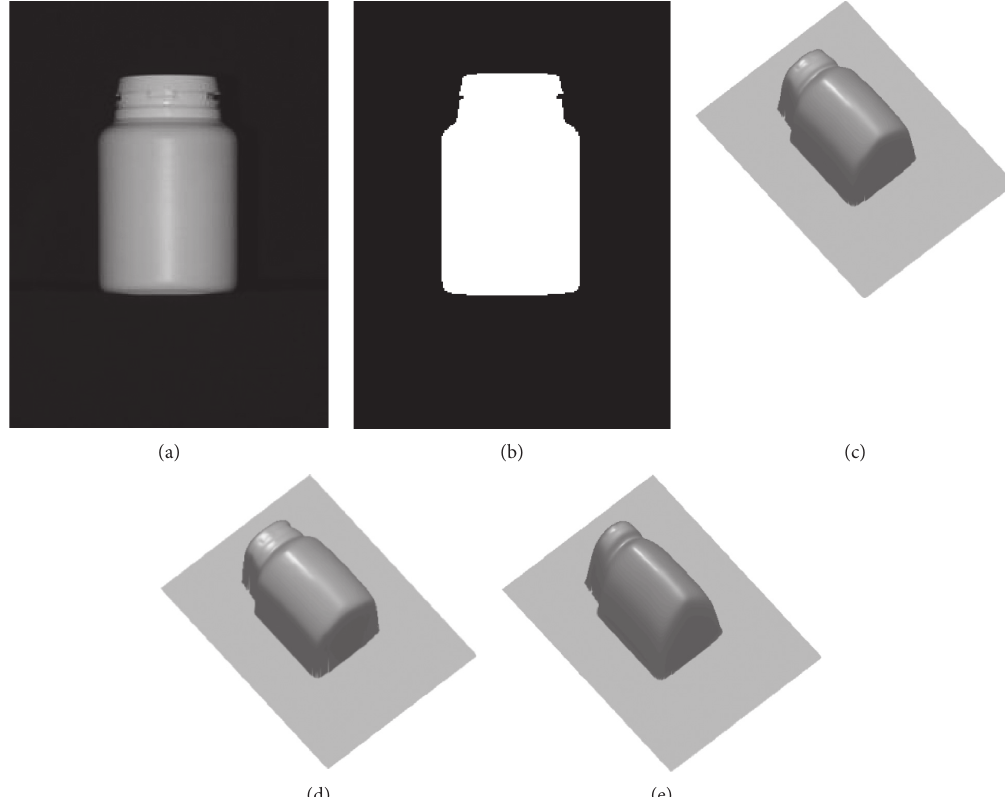
Figure 6: Experimental results for the real bottle image. (a) The real image. (b) The mask of (a). (c) Reconstructed surface of (a) using first- order Godunov-based scheme. (d) Reconstructed surface of (a) using high-order Godunov-based scheme. (e) Reconstructed surface of (a) using Lax–Friedrichs sweeping scheme.